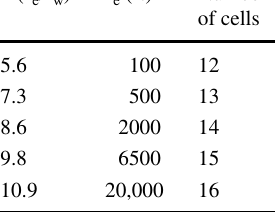
Table 2 Results of minimum total number of cells with different reservoir external radius for the target error of 1%